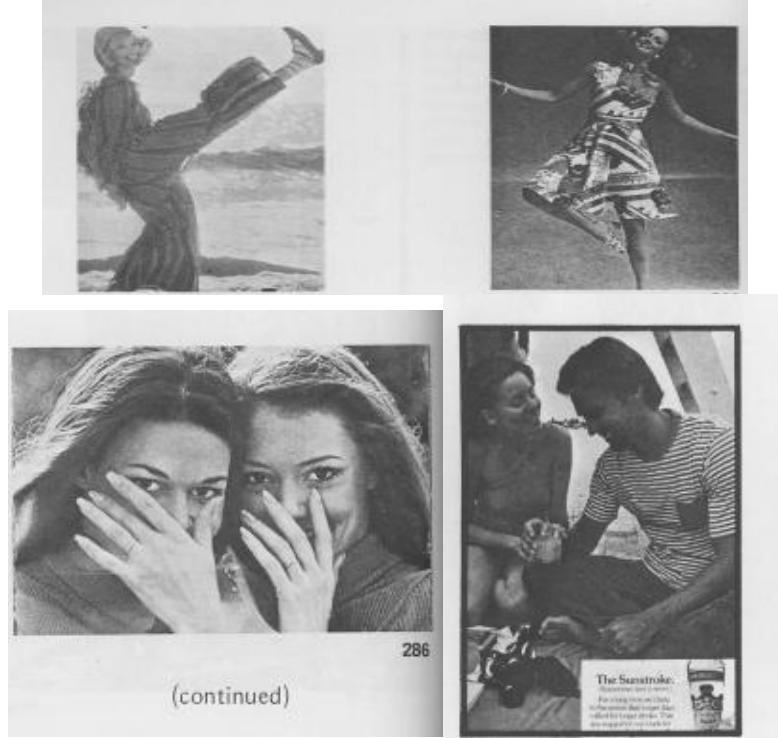
Figure 8. Goffman’s picture, women in clowning, emotional women and women in background. After the analyses, no picture represents this kind of